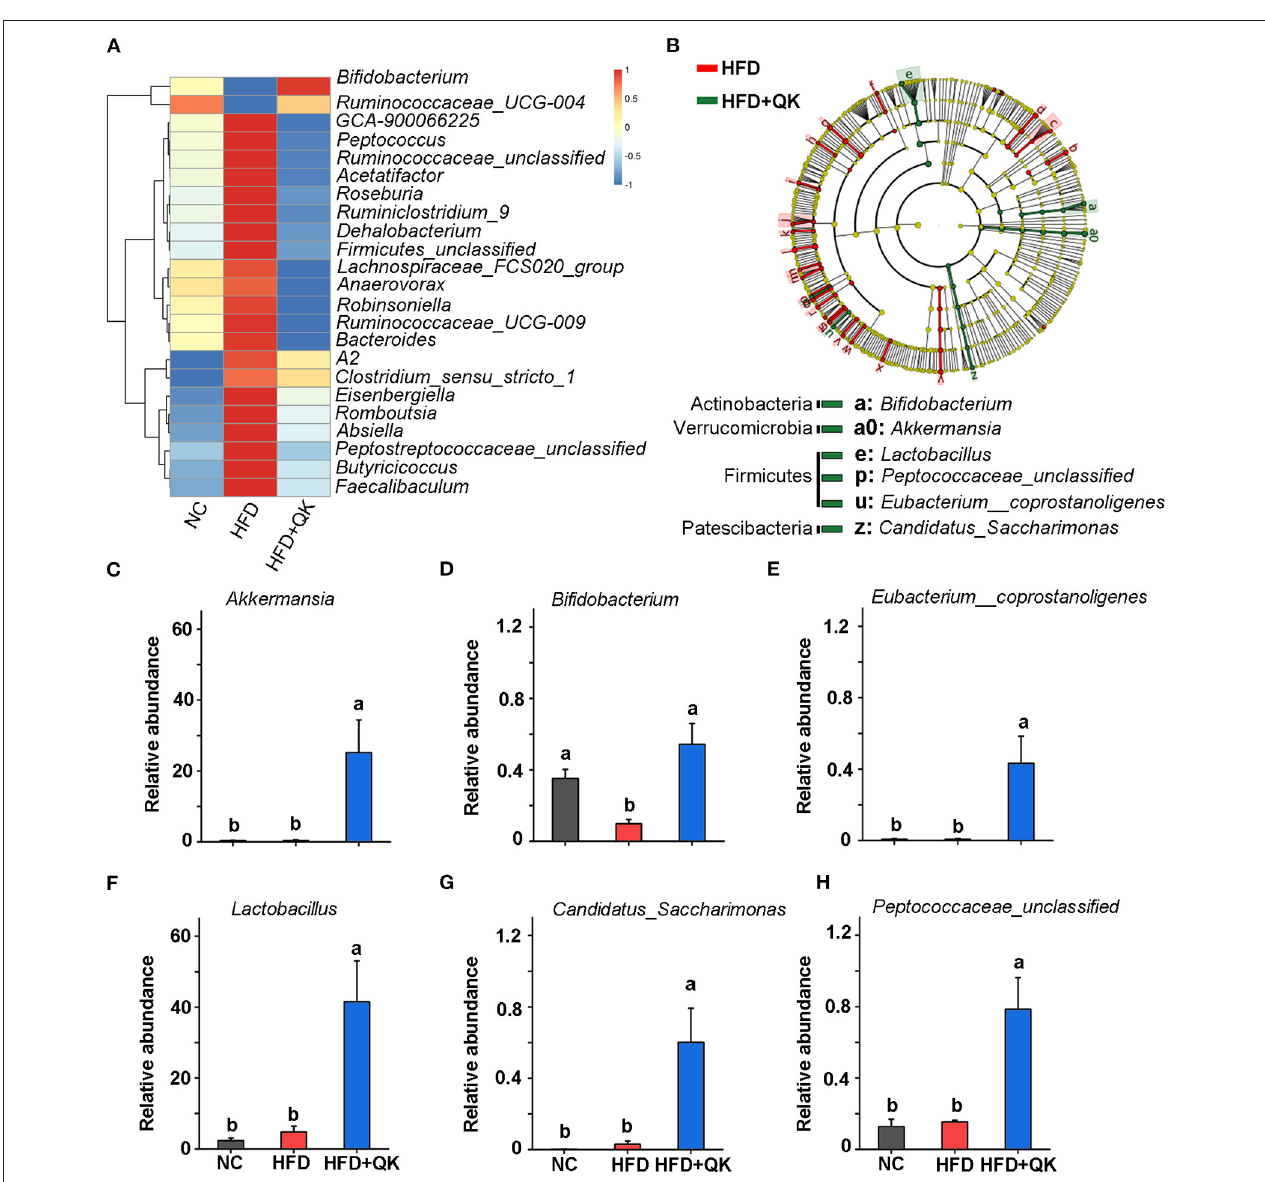
FIGURE 5 | Effects of WGQK on the abundance of five key gut bacteria (genus-level). (A) Heat map of the significant differential genera in the HFD and WGQK mice groups; (B) LEfSe analysis (Kruskal-Wallis < 0.01 Wilcoxon test < 0.01, LDA score > 3) of HFD vs. HFD + QK (for a clearer display of the key bacteria, only show genus and phylum-level enrichment in the HDF + QK group); (C–H) The relative abundance of six key genera enriched by WGQK, (C) Akkermansia ; (D) Bifidobacterium ; (E) Eubacterium__coprostanoligenes; (F) Lactobacillus Peptococcaceae_unclassified ; (G) Candidatus_Saccharimonas ; (H) Eubacterium__coprostanoligenes. Data are presented as mean ± SD ( n = 5), significant difference was determined using an unpaired two-tailed t -test, different superscript letters of any two means represent significant differences ( p <